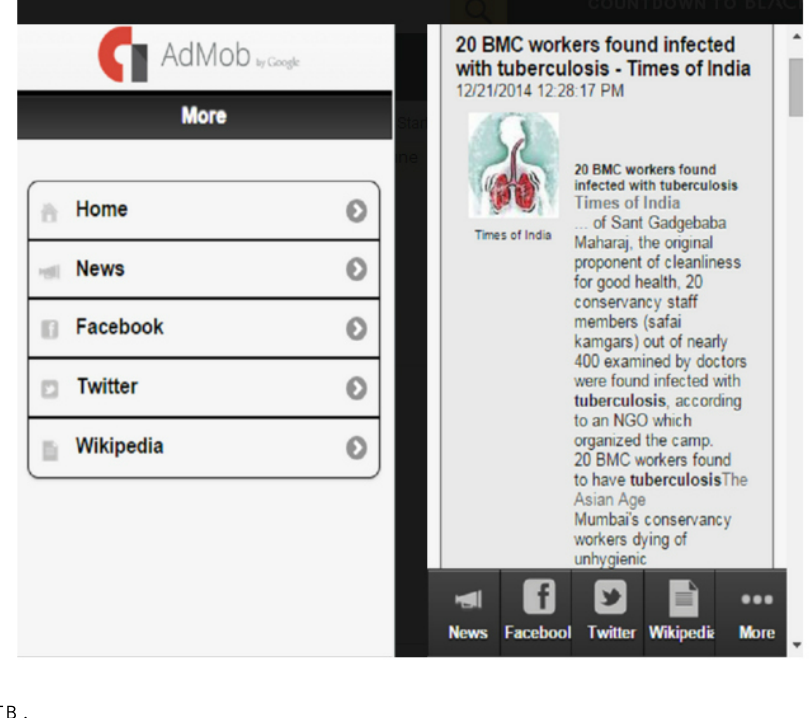
Figure 2. Tuberculosis News, TB Proof.